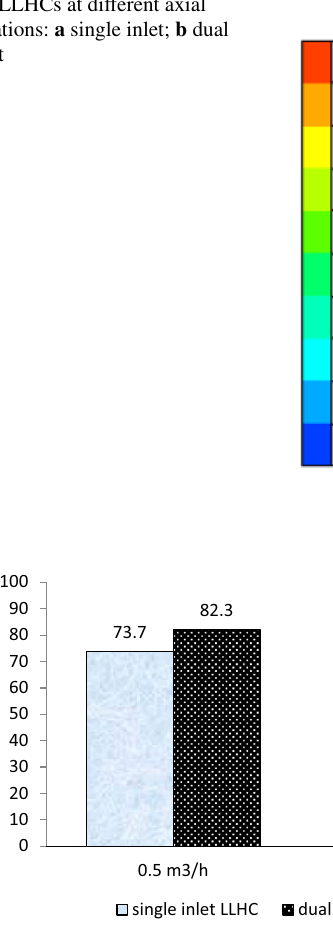
Fig. 10 Continuous phase concentration/pressure within the LLHCs at different axial locations: a single inlet; b dual inlet